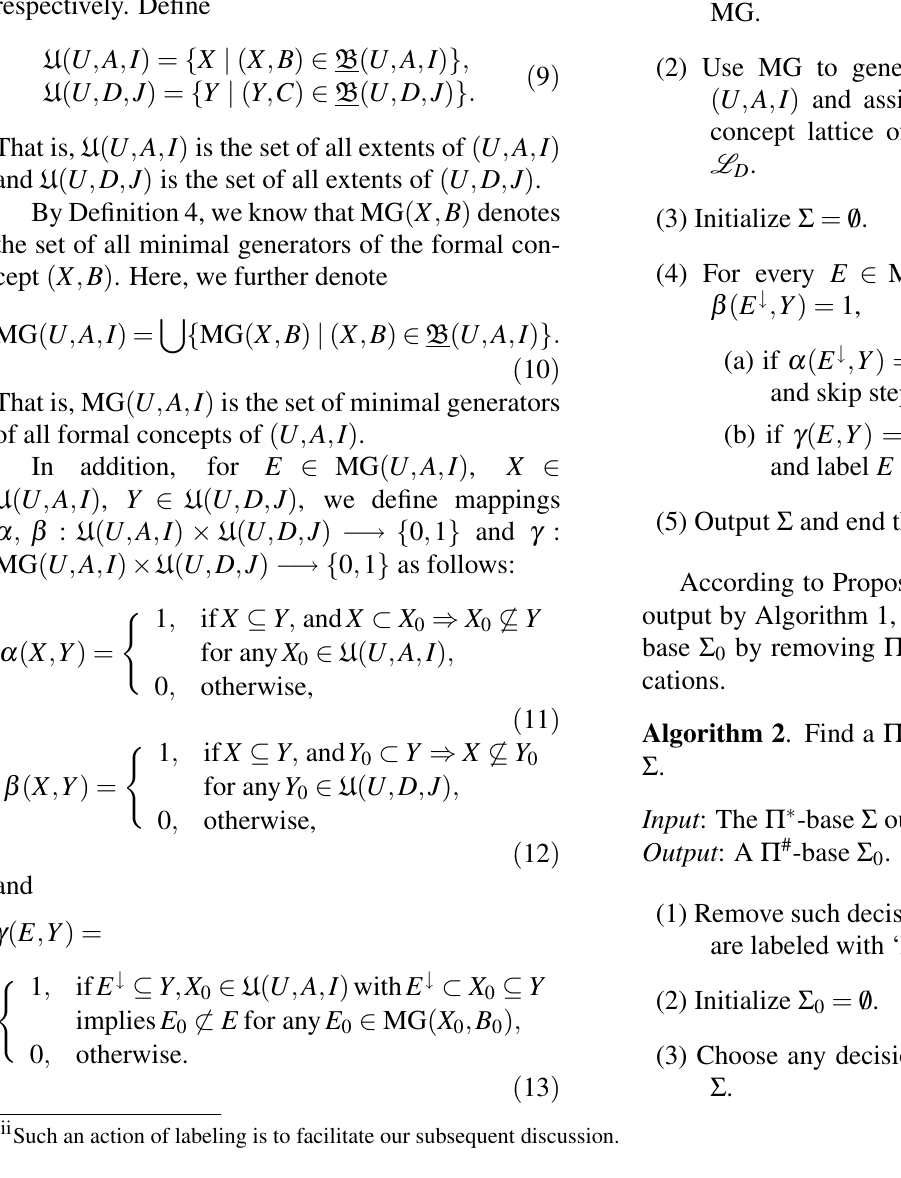
Algorithm 1 . Find a Π ∗ -base of a decision formal context K